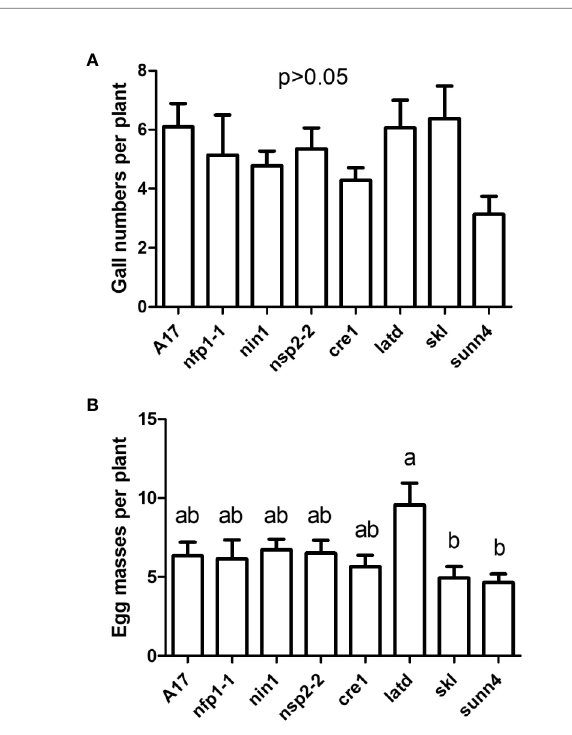
FIGURE 4 | Gall and nodule formation in M. truncatula WT and nodulation mutants. Plants were either infected by nematodes only (N), by rhizobia only (R), or by rhizobia and nematodes at the same time (NR). Phenotypes were recorded 3 weeks after inoculation. (A) Number of galls per plant. (B) Number of nodules per plant. (C) Total number of galls and nodules. N = 25 plants for each genotype. Graphs show means and standard errors. Means with different letters differ signi fi cantly from each other with p < 0.05 (two-way ANOVA with Bonferroni